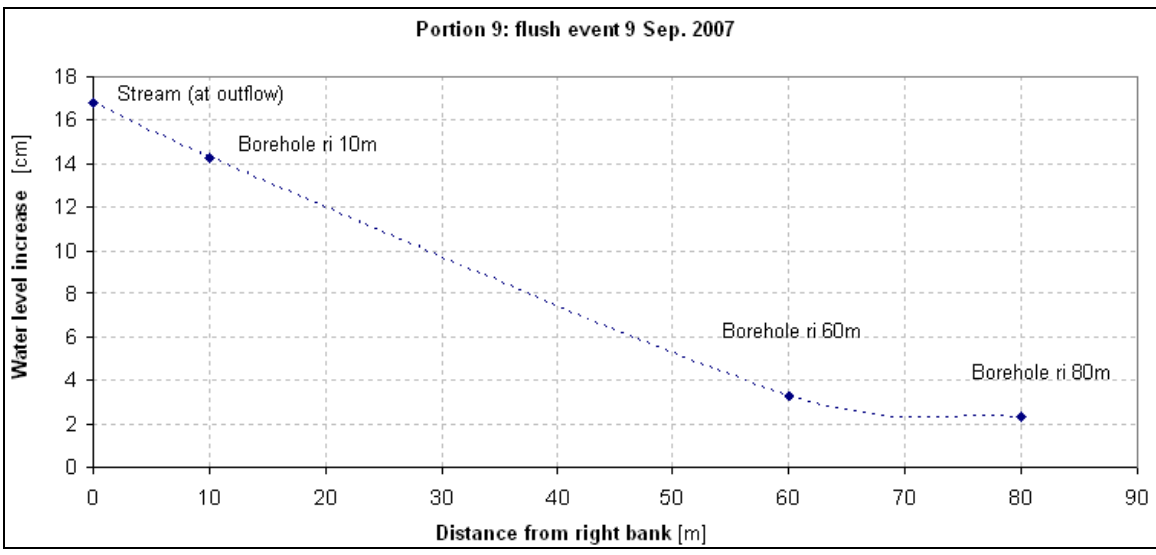
Figure 24. Relationship between the increase water levels in boreholes and their distance from adjacent stream indicating that the rise in groundwater level associated with rising stream levels is highest near the stream and decreases non-linearly with increasing bank